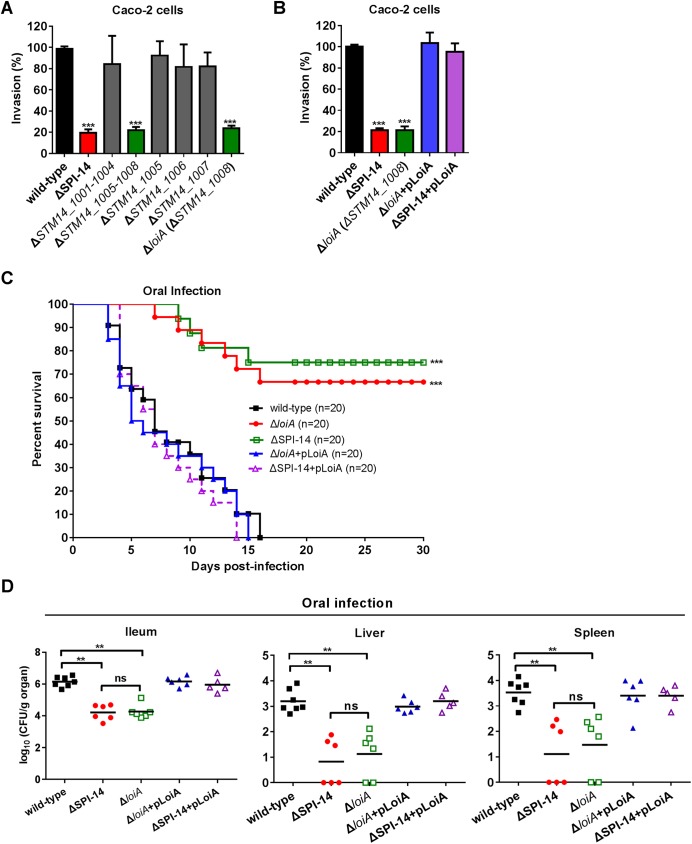
The gene loiA (STM14_1008) is the virulence determinant in SPI-14 influencing S. Typhimurium invasion.(A) Invasion assays of wild-type, SPI-14 mutant, STM14_1001-STM14_1004 mutant, STM14_1005-STM14_1008 mutant, STM14_1005 mutant, STM14_1006 mutant, STM14_1007 mutant and loiA (STM14_1008) mutant. (B) Invasion assays of wild-type, SPI-14 mutant, loiA (STM14_1008) mutant and complemented strains. For (A) and (B), Caco-2 cells were infected with bacteria at an MOI of 10. The invasion ability of mutants is reported as percentages relative to the wild-type strain. Data are representative of at least three independent experiments and are presented as mean ±SD. P values were determined by student’s t test (***P<0.001). (C) Survival plots of BALB/c mice over a 30-day period after orally infected with ~5×106 CFU of indicated bacterial strains. Data presented are the combination of three independent experiments, ***P<0.001 by log-rank curve comparison test. (D) Bacterial counts recovered from ileum, liver and spleen of the orally infected mice. At day 5 post-infection, mice organs were harvested and homogenized for colony enumeration. Data are combined from three independent experiments. Bars represent mean CFU of all mice, with P value determined by the Mann-Whitney U test (**P<0.01; ns, not significant).